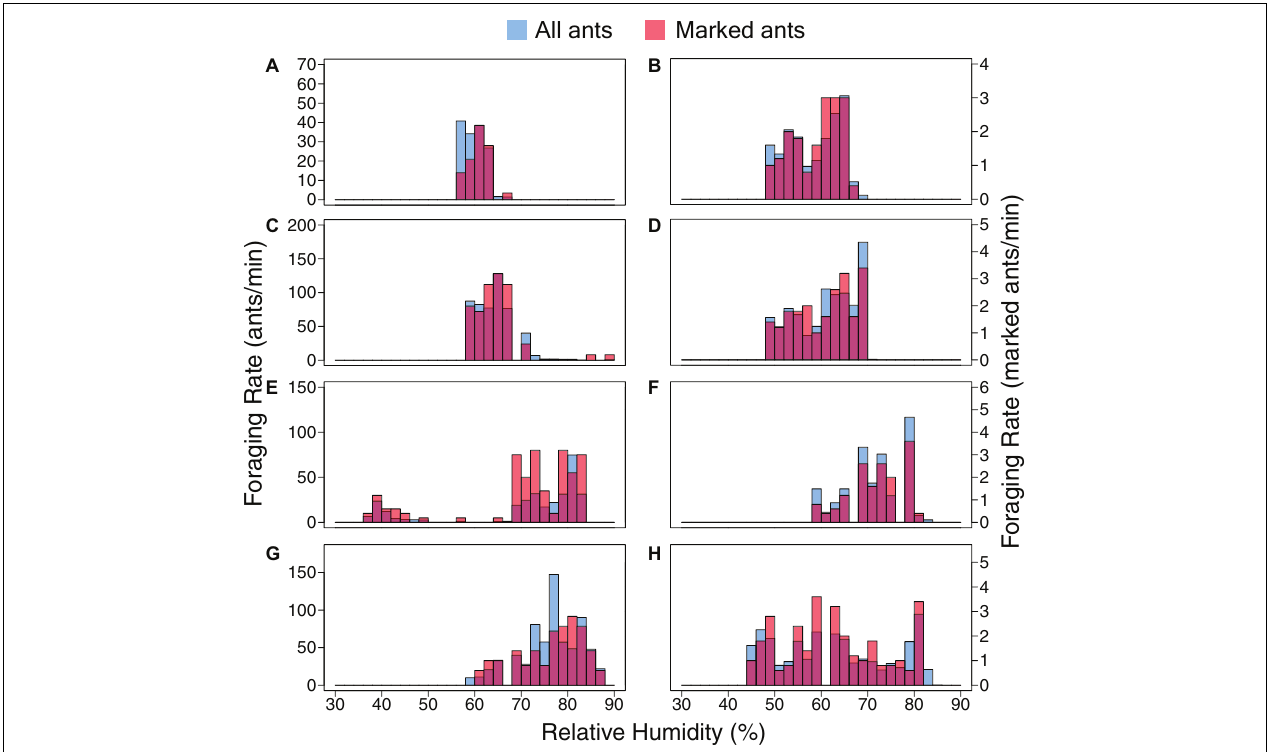
FIGURE 2 | Distributions of outgoing foraging rate as a function of relative humidity. Data for all ants are shown in solid blue, for marked ants in red. The distribution of foraging rate (i.e., the number of outgoing foragers per minute) in response to humidity for marked foragers is similar to that of all foragers ( Table 2 ). Each row of two panels shows the data for Days 1 and 2 for one colony: (A) Colony 859, August 20, 2017; (B) Colony 859, August 21, 2017; (C) Colony 1107, August 20, 2017; (D) Colony 1107, August 21, 2017; (E) Colony 1242, August 22, 2018; (F) Colony 1242, August 23, 2018; (G) Colony 1368, August 24, 2018; (H) Colony 1368, August 25, 2018.